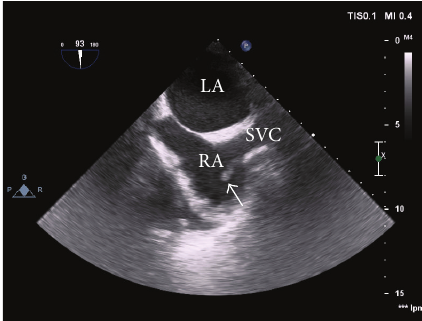
Figure 3: Computed tomography showing a 13 × 10 × 16cm abscess (A), compressing the liver (L); abdominal aorta (Ao); kidney (K); spleen (Sp); stomach (St).